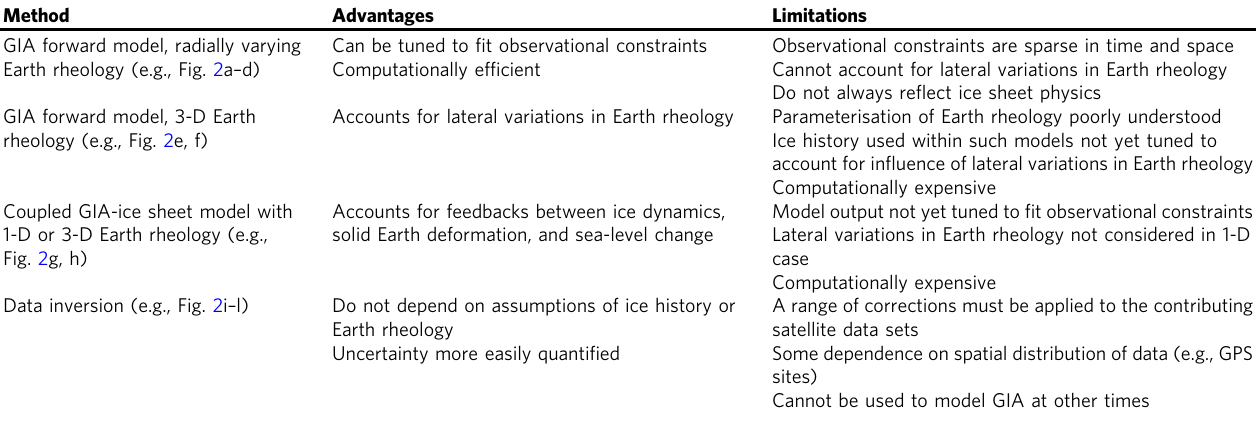
Table 1 Advantages and limitations of four approaches used to determine the present-day GIA signal across